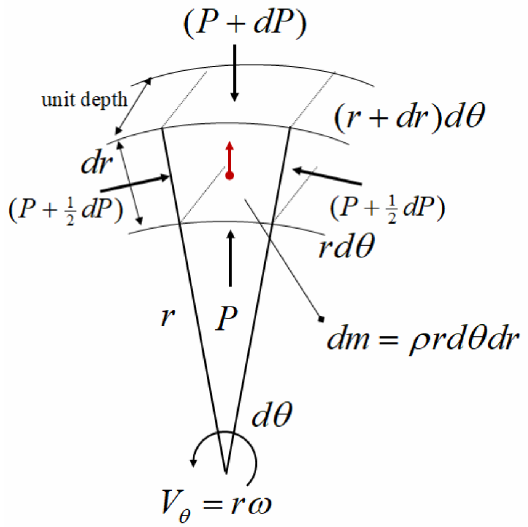
Figure 5. Schematic of the fluid element of mass, dm swirling about the vortex axis at the rate, ω . The fluid element is in radial equilibrium by the balance between the pressure force and centrifugal force acting on